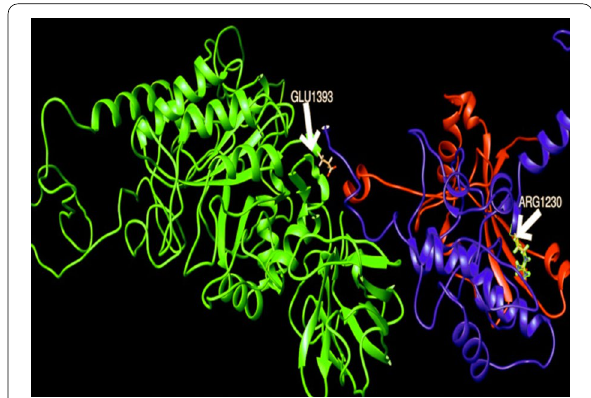
Fig. 5 The modeled 3D structure presicted by modeller 9.23 and viewed by UCSF chimera. The 3D structure appeared as a trimer (3 chains: A,B,C) chain A (Blue colored), Chain B(Green colored) and chain C(Red coolorred) and labelled by the positions of the two